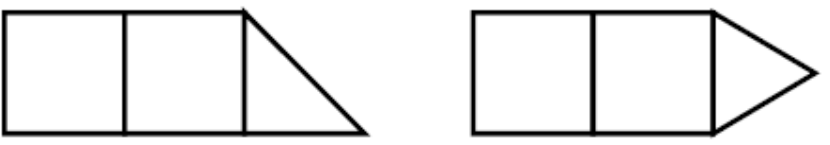
Figure 5. Examples of configurations of the rods parallel to the ground (upper view).